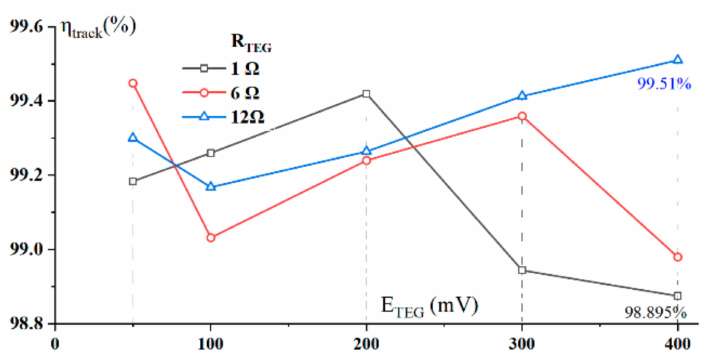
Figure 12. Tracking efficiencies of the proposed circuit at different conditions.